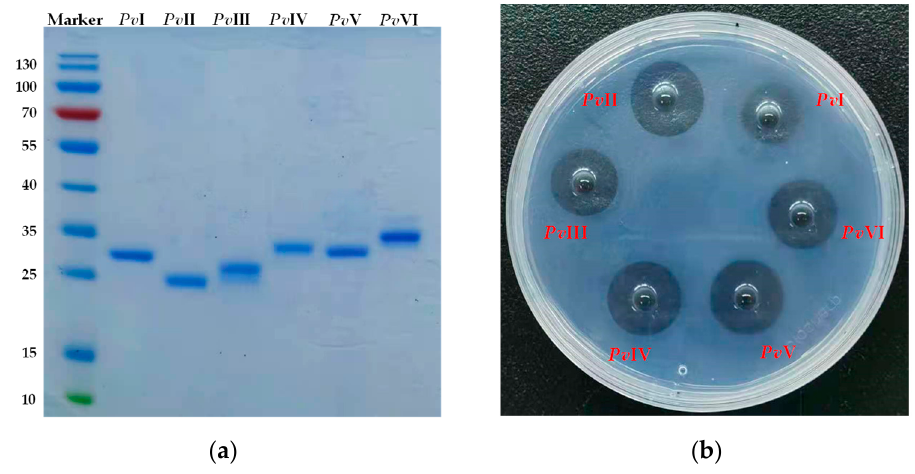
Figure 7. ( a ) Profiling of six novel P. vulgaris- derived proteases; and ( b ) the fibrinolytic activity of each protease.